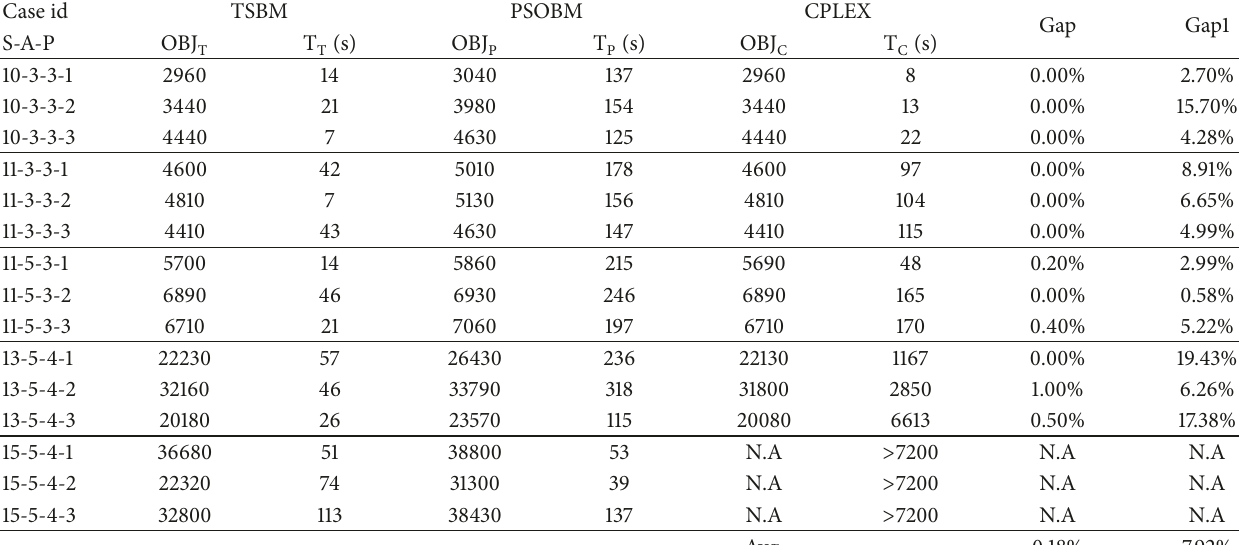
Table 1: The performances of the proposed solution